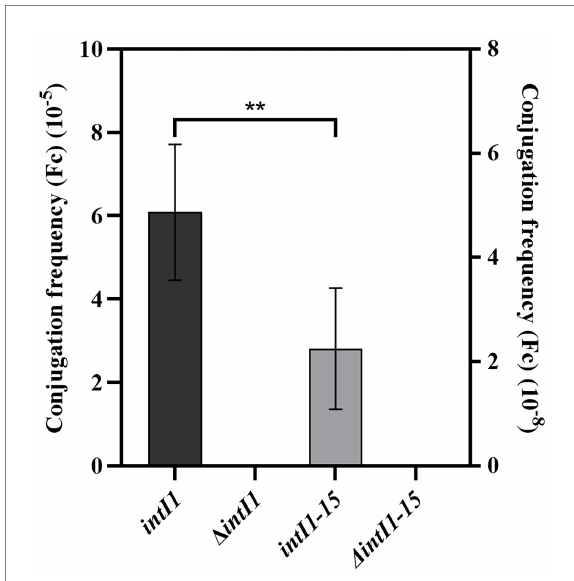
FIGURE 5 The conjugation frequency (Fc) of intI1 and intI1-15 . ** p < 0.01.